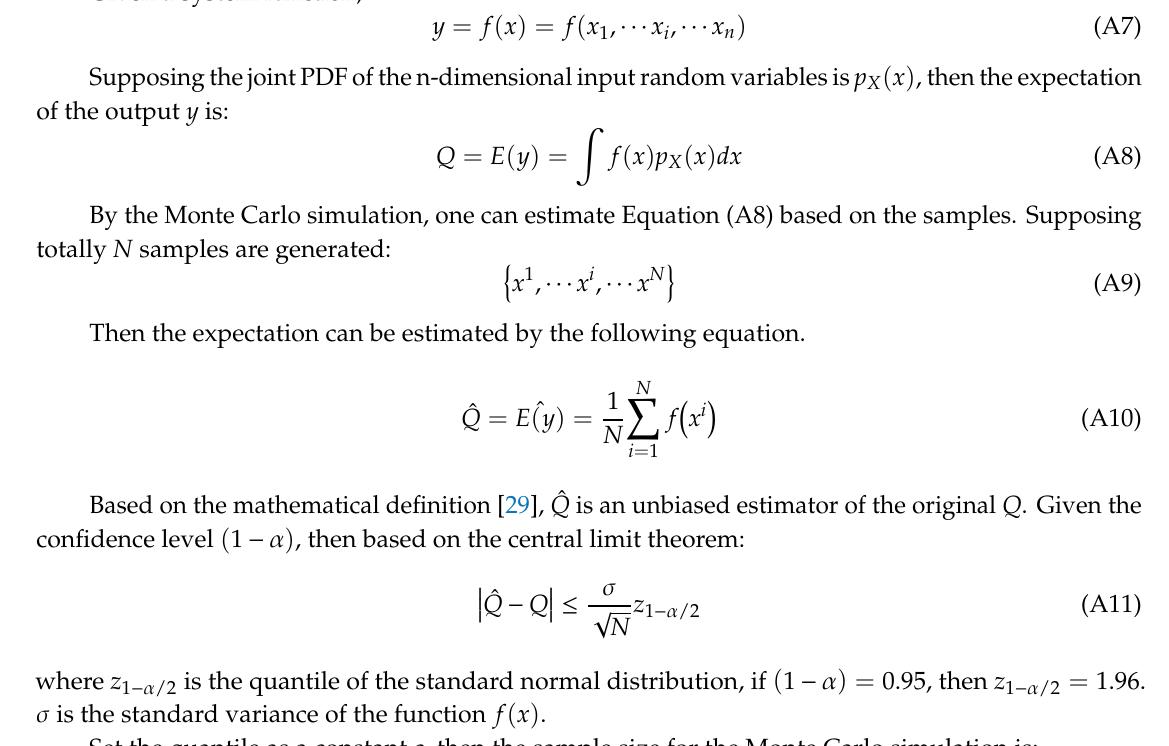
Figure A2. Rotation of a plane.